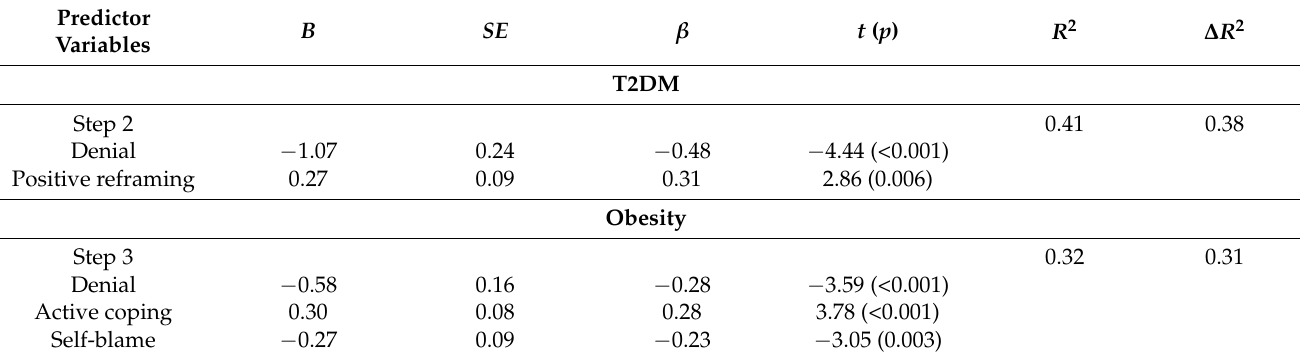
Table 8. Coping Strategies as Predictors of Quality of Life (Total